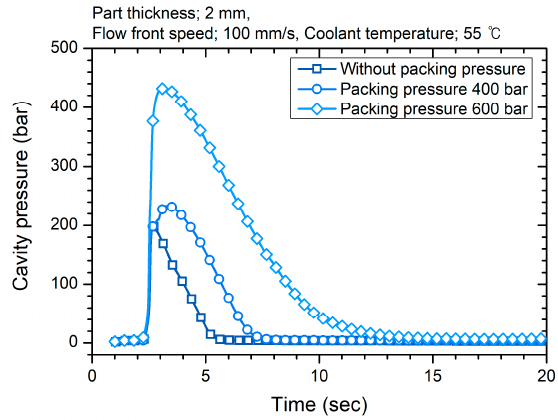
Figure 3. Cavity pressure under different packing pressure conditions.